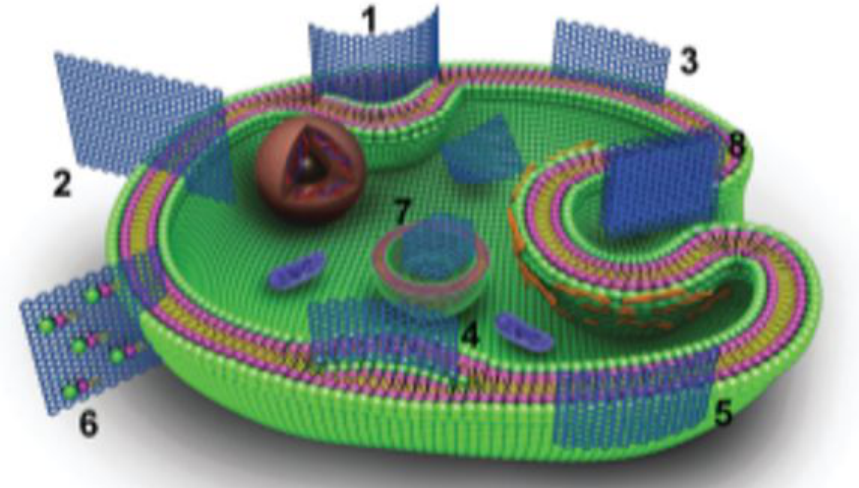
Figure 2. The schematic representation of the possible interaction states between graphene and cell: (1) hemisphere vesicle structure, (2) lying across the membrane (3) graphene-sandwiched superstructure, (4) flat vesiculation, (5) adhering to the membrane surface, (6) destructive extractions of lipid molecules from the membrane, (7) cytoplasmic internalization, and (8) actin filament mediate endocytosis. Partially reproduced from Reference [30], with permission of the Royal Society of Chemistry